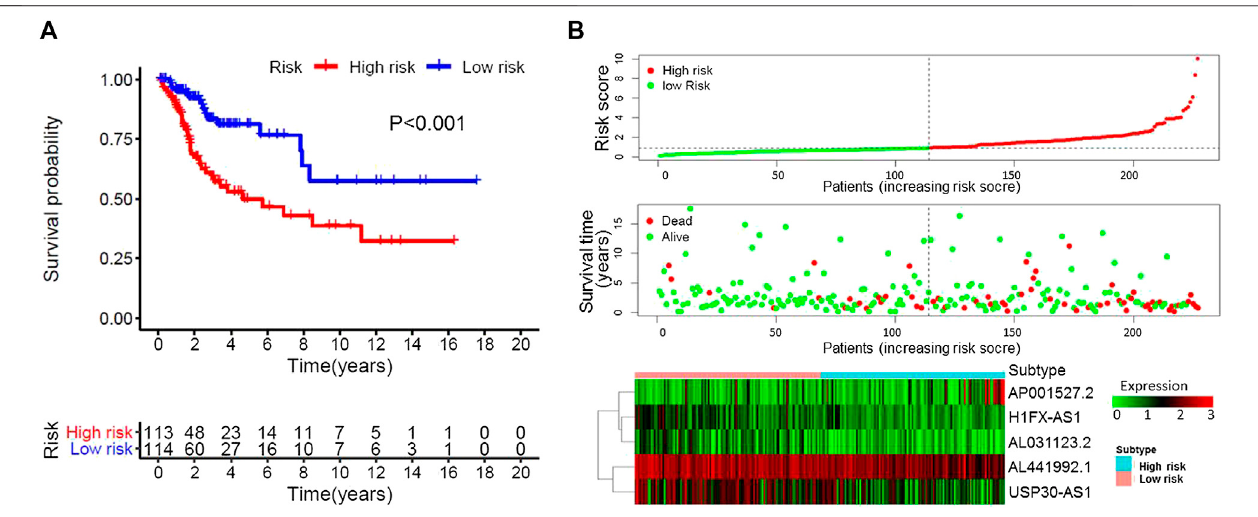
FIGURE2 | Characteristics ofthe patients inthe combination set based on the constructed model. (A) ,Kaplan – Meier curve ofthe high-risk and low-risk groups of combination setshoweddifferences insurvivalrate. (B) ,Distribution ofriskscore, survivalstatus ofeach patients,and heatmapexpression of fi ve immune-related Long non-coding RNAs in high-risk and low-risk groups were